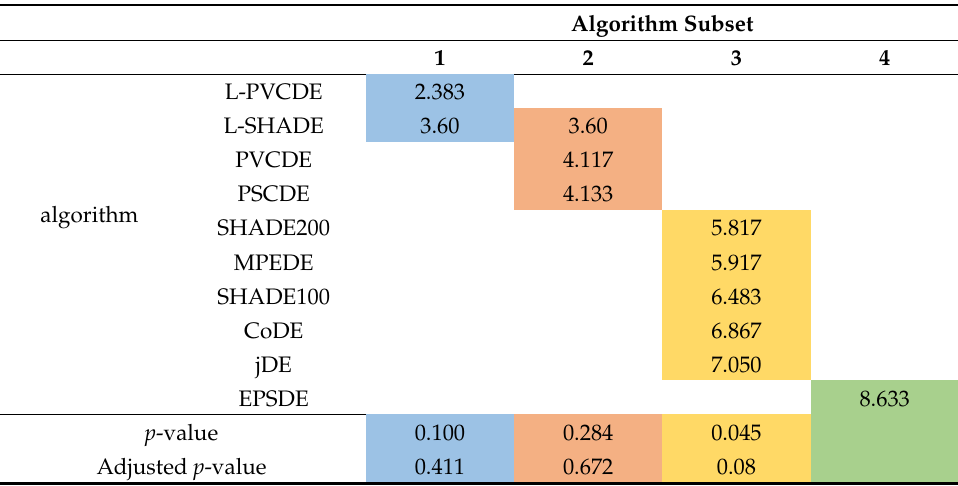
Table 8. The uniform Subsets of Algorithms (Friedman test by